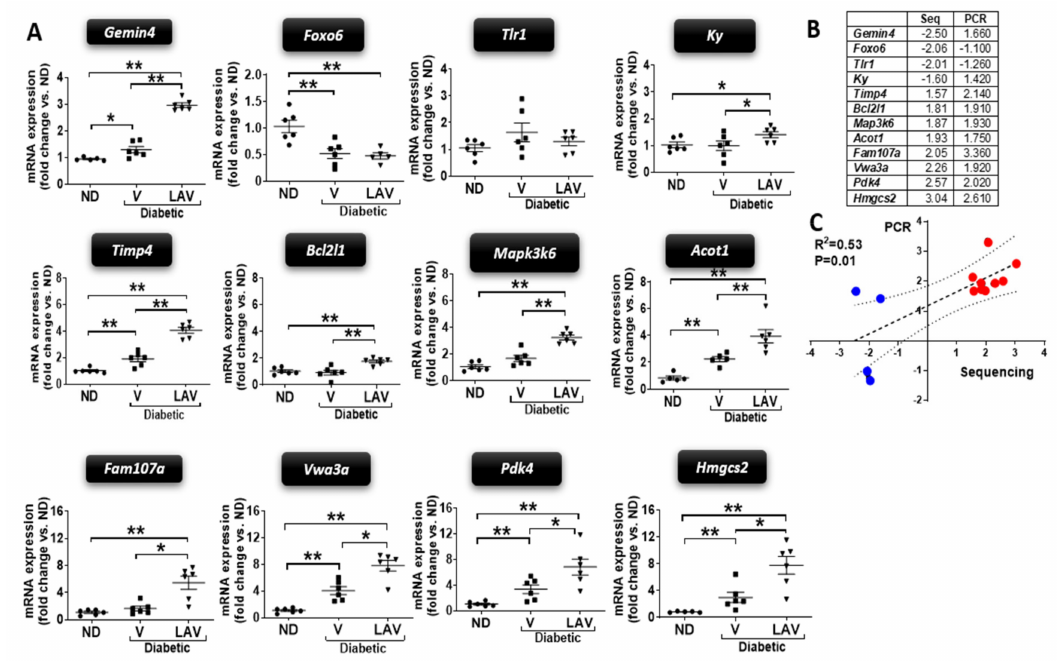
Figure 2. Validation of sequencing data by RT-qPCR (Study 2). ( A ) Graphs showing the mRNA levels of 12 genes found di ff erentially modulated by the LAV-BPIFB4 treatment in type-2 diabetic db / db mouse hearts. RT-qPCR was performed on the samples from sequencing, plus additional animals, for an n = 6 animals per group (non-diabetic, ND; PBS vehicle-treated diabetic, V; and LAV-BPIFB4 -treated diabetic, LAV). Data (fold changes vs. ND) are expressed as individual values and mean ± SEM. * p < 0.05 and ** p < 0.01. ( B ) Comparison of fold changes from the two methodologies. ( C ) Linear regression indicating the correlation of data from the two